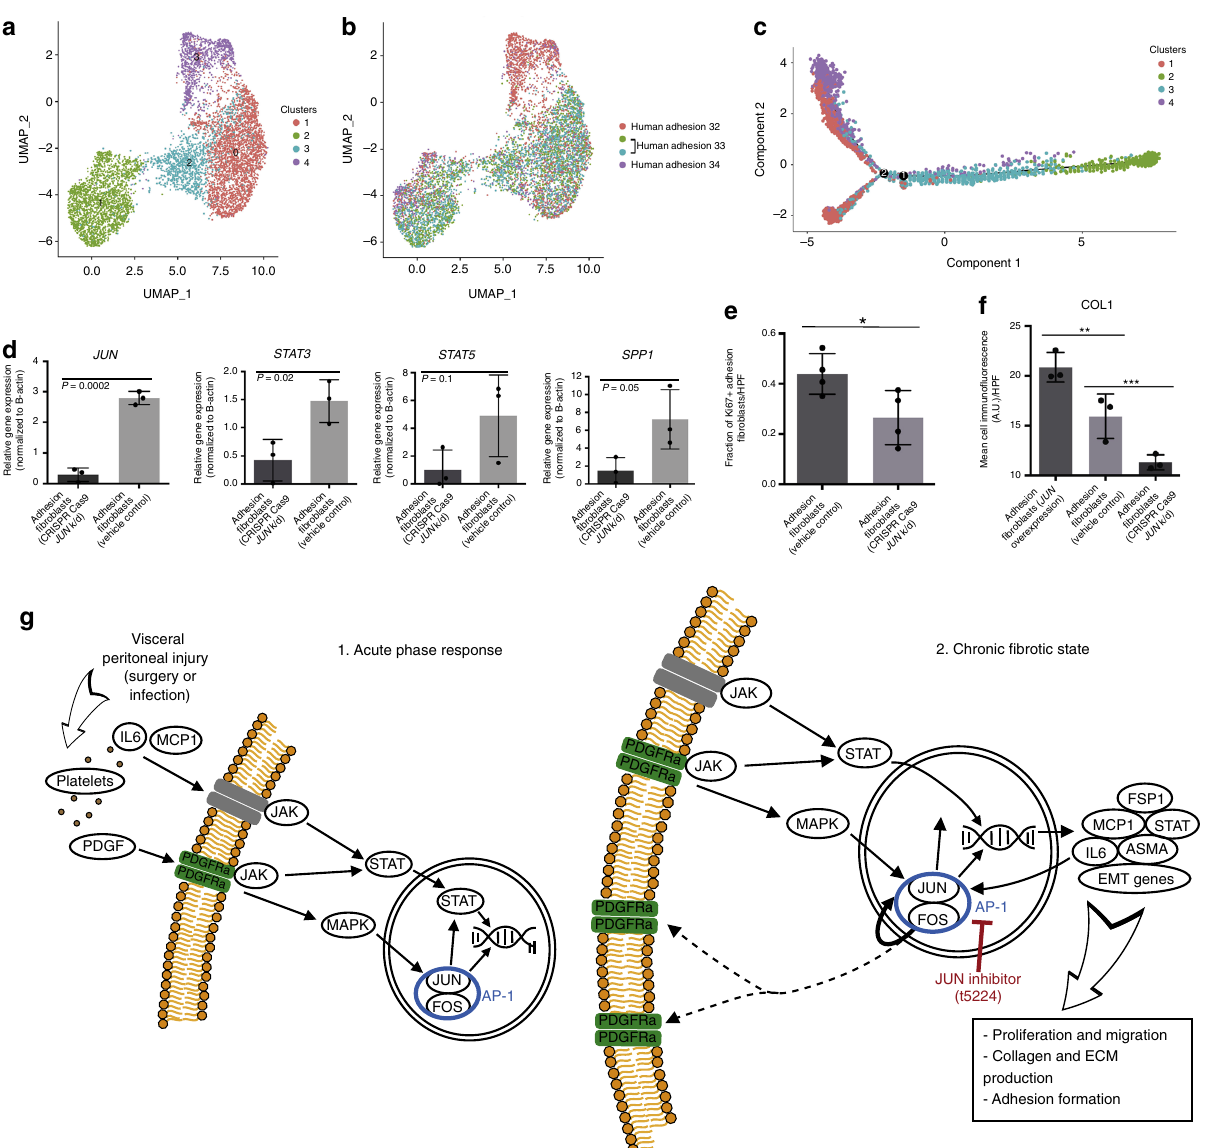
Fig. 8 Human adhesion fi broblasts are heterogeneous and JUN dependent. a Uniform manifold approximation and projection (UMAP) plots showing single-cell (sc)RNA-seq data from human adhesion fi broblasts FACS-isolated using an unbiased, lineage-negative sort strategy from three unique human specimens. Four unique clusters are identi fi ed. b UMAP plot showing representation of individual patient samples (arbitrarily numbered) across the cluster presented in 1 . Human hashtag labels indicated at right, 2 hashtag antibodies were used for patient 33 as an internal control, as noted in the fi gure panel legend. c Pseudotime analysis of human abdominal adhesion fi broblast scRNA-seq data. Colors match cluster colors assigned in panel a. d Quantitation of qPCR analysis for JUN , STAT5 , STAT3 , and SPP1 of vehicle control versus JUN CRISPR Cas9-knockdown human abdominal adhesions fi broblasts. P -values noted in fi gure. n = 3 replicates per condition, datapoints represent average of technical replicates. e Quantitation of Ki67 expression using ICC of primary human abdominal adhesions fi broblasts treated with CRISPR Cas9 JUN knockdown compared with vehicle control. n = 4 biological replicates assessed per condition. f Quantitation of collagen type 1 expression using ICC of primary human abdominal adhesions fi broblasts treated with virally mediated JUN overexpression, vehicle control, or CRISPR Cas9 JUN knockdown. n = 3 biological replicates assessed per condition. g Schematic (based on published KEGG pathways) displays proposed JUN -relevant signaling pathways identi fi ed in this study. The left panel shows the acute phase response following tissue injury by which JUN is initially activated. The right panel shows the chronic pro fi brotic state that is established in adhesion fi broblasts. Blue circle highlights AP-1, red indicates the role of JUN inhibitor. Colors as labelled in the fi gure. ECM extracellular matrix. Data and error bars represent means ± SD. HPF high power fi eld. A.U. arbitrary units. * P = 0.04, ** P = 0.03, *** P = 0.03, unpaired two-tailed t -test. Source data are provided as a Source Data fi JUN as a transcriptional master regulator of fi broblasts. auto-ampli fi es, acting as a pro fi brotic transcription factor via Mechanical injury in the form of abdominal surgery or intra- several downstream signaling responses including JAK - STAT abdominal infection insights a local wound healing response and EMT pathways. These fi broblasts take over production of that involves platelet aggregation at the site and associated IL6 and related factors resulting in a chronic, high- JUN , PDGF and IL6 release. These factors initially precipitate JUN pro fi brotic state through which adhesions are maintained expression (Fig. 8g — left panel). Once induced, JUN signaling inde fi nitely (Fig. 8g — right panel). Suppression of JUN pathway